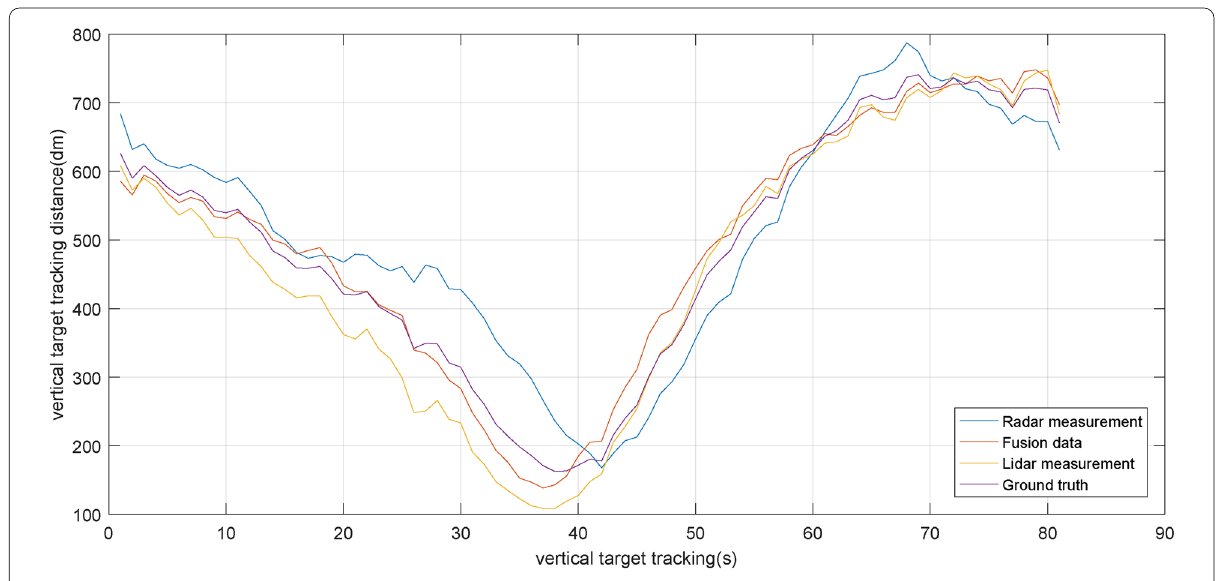
Figure 8 Vertical tracking results of autonomous vehicle